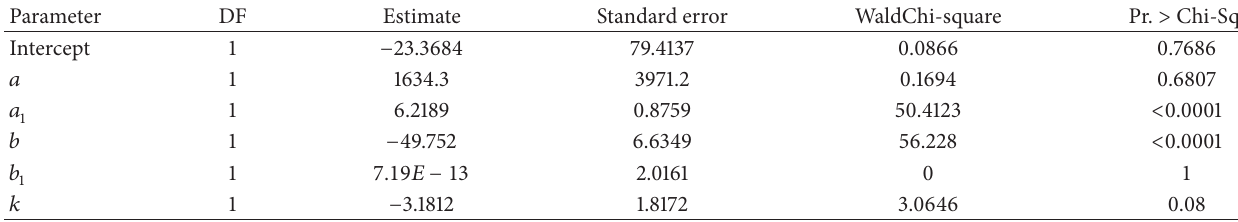
Table 8: Analysis of maximum likelihood estimates.